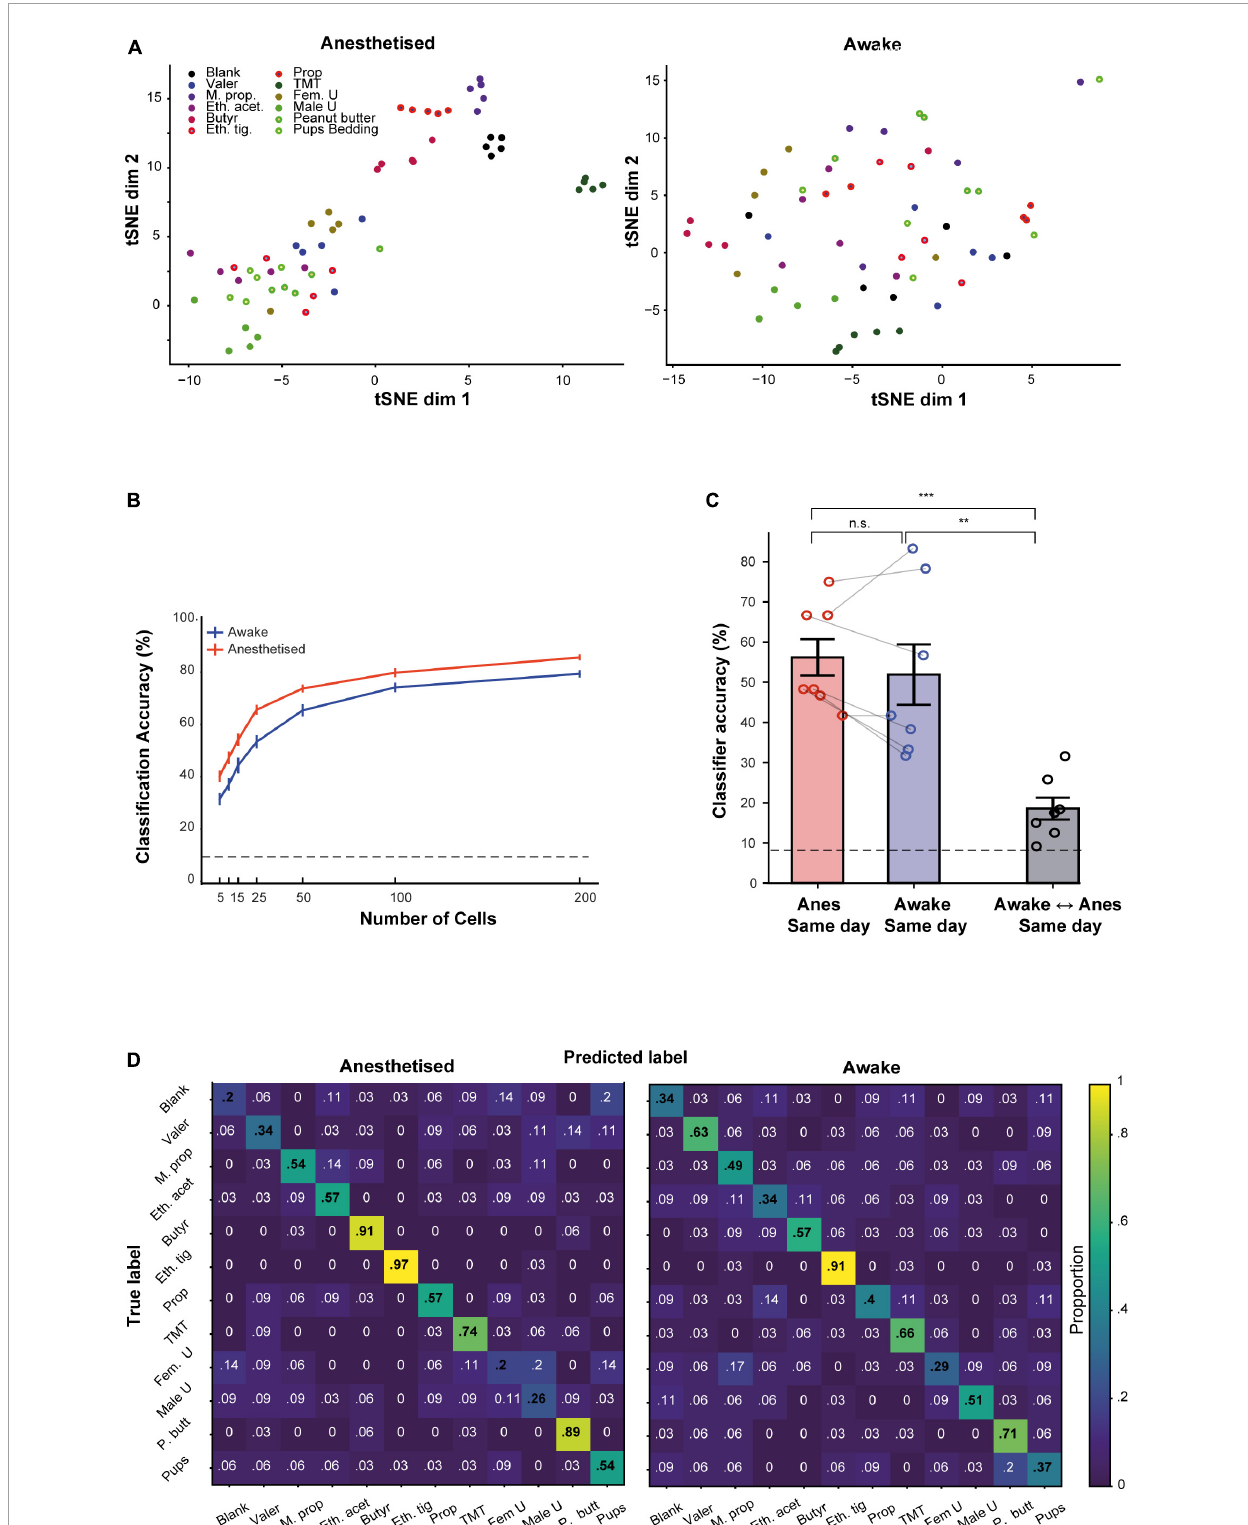
FIGURE6 Odor representation by the population of mitral cells (MCs) in awake and anesthetized states. (A) Two-dimensional t-SNE representation of neural responses. Data represent the pooled MC responses in one example mouse, during anesthesia (left) and wakefulness (right). Each dot is a trial; each color is an odor. (B) The accuracy of a linear classifier in identifying the correct odor, as a function of the number of MCs used for the task. MCs are randomly pooled from all mice. Error bars are SEMs calculated over 40 simulations. Dashed line represents chance level. (C) The average accuracy of a linear classifier for different training-testing configurations, using data collected within the same day. (D) Confusion matrices for a classifier that was trained to distinguish between different odors, averaged over all seven mice in anesthetized (left) and awake (right) sessions. ** p < 0.01; *** p <